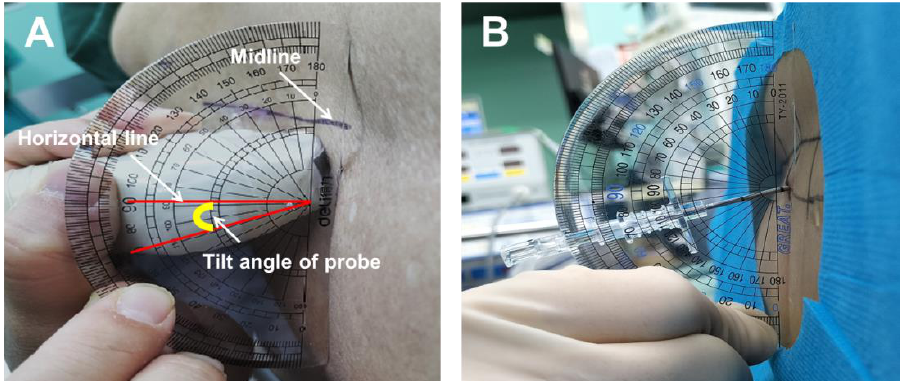
Figure 4. Measurement of tilt angle of probe under paramedian sagittal oblique scan and the use of the tilt angle for instructing the puncture angle. The tilt angle was defined as the included angle between the horizontal line and the ultrasound beam (Panel ( A )). A protractor was used to instruct the needle insertion at the tilt angle measured in advance (Panel ( B )).